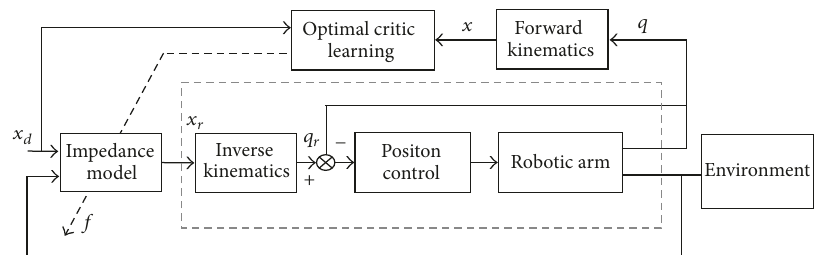
Figure 6: Block of the learning impedence